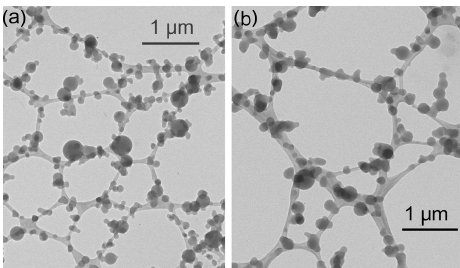
Figure 1. TEM images of tar balls generated from (a) black locust ( Robinia pseudoacacia ) and (b) Norway spruce ( Picea abies ).